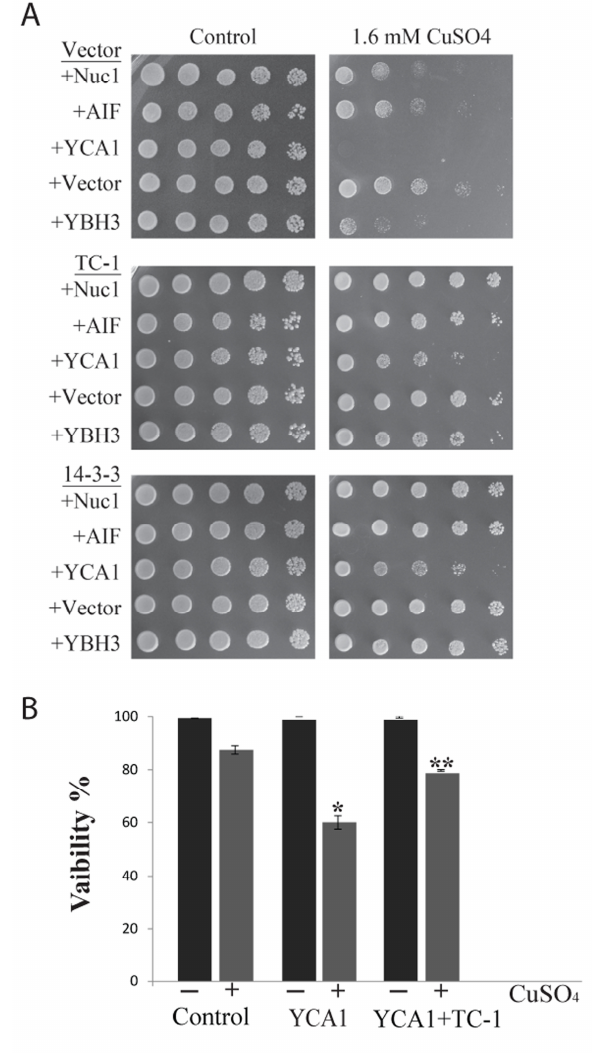
FIGURE 3: TC-1 protects against pro-apoptotic genes. (A) Yeast cells harbouring control plasmid (Vector) or plasmids expressing different pro-apoptotic peptides including NUC1 , AIF , YCA1 or YBH3 were co-transformed with either empty plasmid (Vector) or a plasmid expressing TC-1 or 14-3-3. The spot growth assay was used to assess the growth of the transformants on YNB media with galactose alone (Control) or with a sublethal concentration of copper sulfate (CuSO 4 ). The cells were allowed to grow at 30°C for 3 days and photographs of the plates are shown. (B) Freshly grow- ing cultures of yeast transformants with two empty vectors (Con- trol), one empty vector and a YCA1 expressing plasmid (YCA1) or the YCA1 and the TC-1 expressing plasmids (YCA1+TC-1) were challenged without (-) or with (+) sublethal Yca1 p activating levels of copper (CuSO 4 ). Viability was determined by microscopical ex- amination of at least 300 cells. The data is shown as the percent- age of cells that survive and represents the median ± SEM of at least n = 3 independent experiments. * indicates that the viability of cells expressing YCA1 alone was significantly lower than the viability of control cells while ** indicates that the viability of cells expressing YCA1+TC-1 was significantly higher than the viability of cells expressing YCA1 alone with P-values <